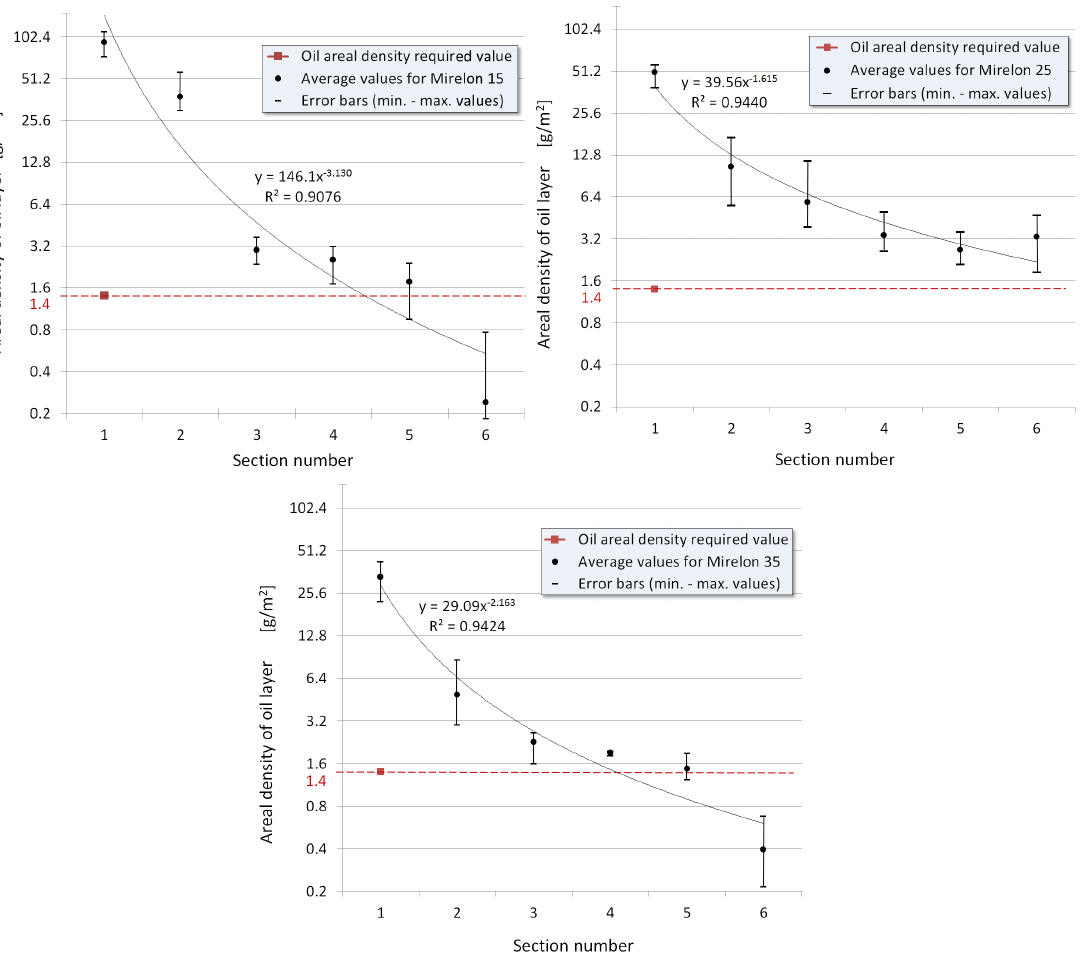
Figure 5. Average values of experimental measurements for all pipe diameters, i.e., 15, 25, and 35 mm. Trendlines demonstrate different behaviour of oil microparticles in tubes of different diameters. Flow rate was constant at all